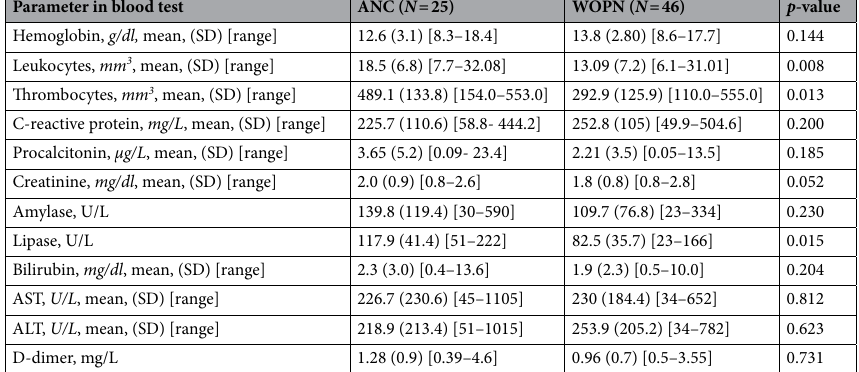
Table 3. Parameters in laboratory blood test on day of the beginning of the endoscopic treatment.